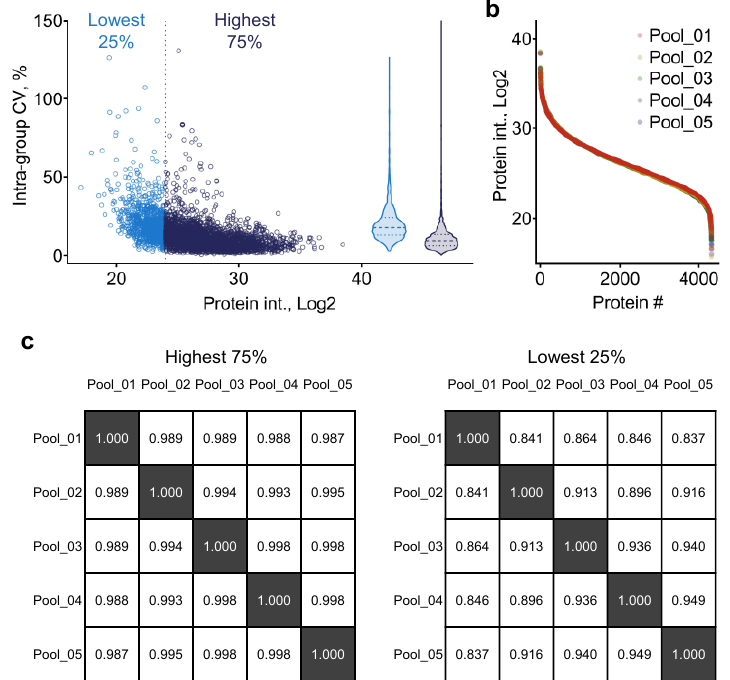
Figure 2. Assessment of LC-MS reproducibility during the analysis queue using the quality control (QC) sample. ( a ) Protein MS intensity-intra-group coefficient of variance (CV) plot. Proteins in the highest 75% and lowest 25% abundance range were shown in dark and light blue color; ( b ) ranked order of protein MS intensities for the 5 QC sample runs; ( c ) Pearson correlation matrices of the QC sample runs using proteins in the highest 75% and lowest 25% abundance range.